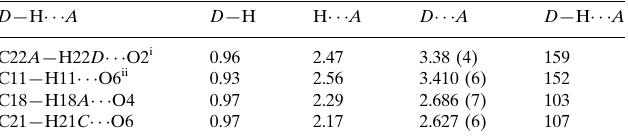
Hydrogen-bond geometry (A˚ , (cid:1)